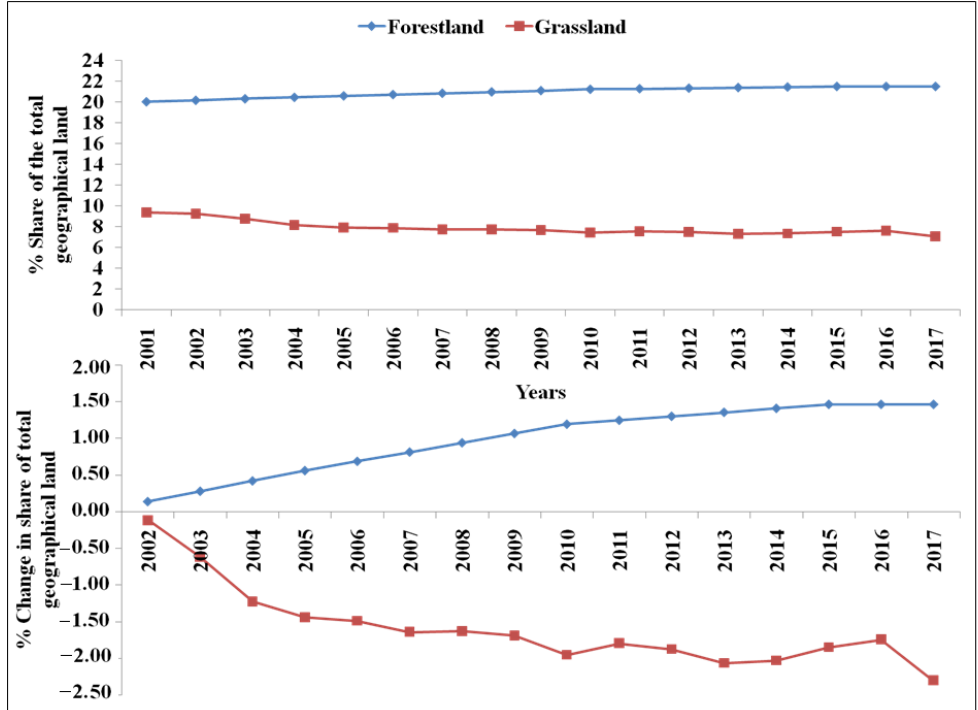
Figure 1. Trends of percent share and change in share (base year 2001) of grassland and forestland area of total land area (2001 – 2017) of India, Food and Agriculture Organization (FAO)[19].